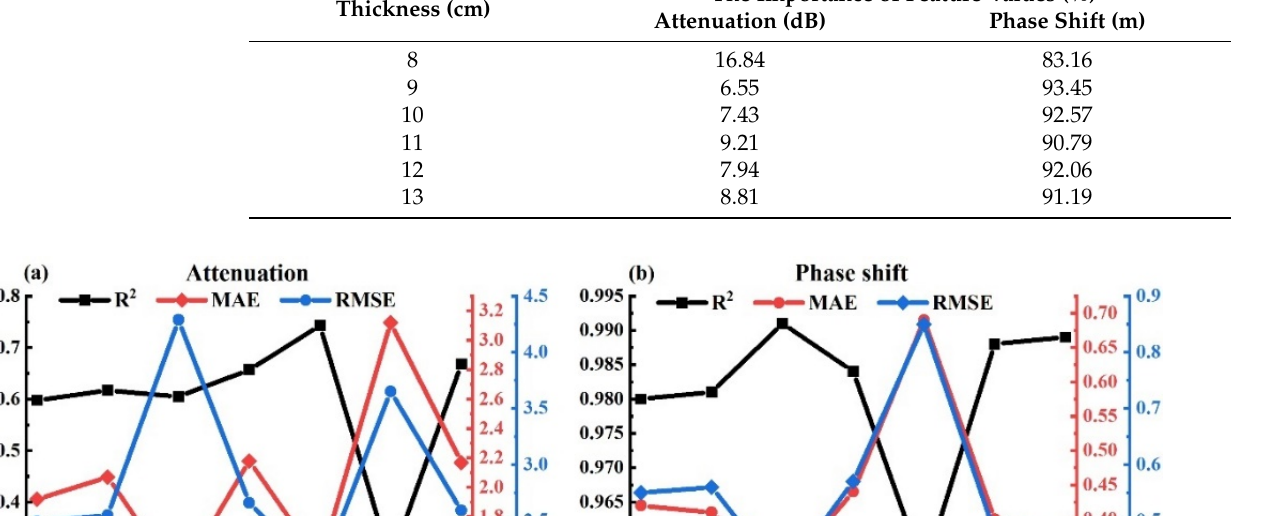
Table 1. Feature importance.